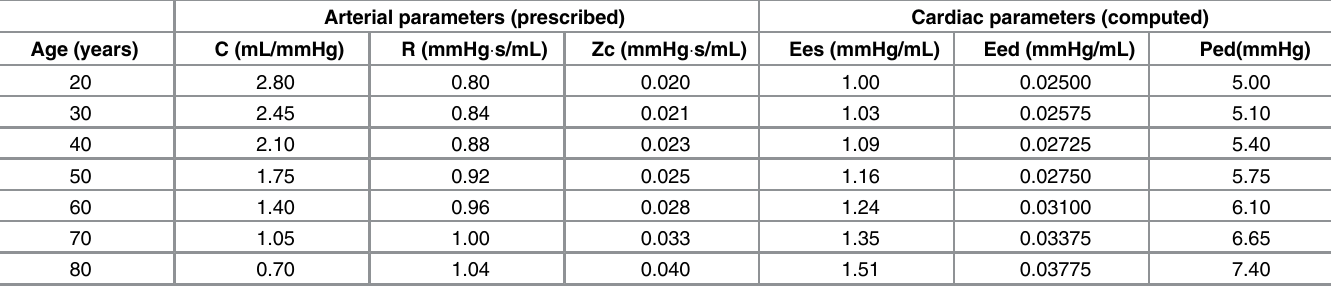
Table 1. Arterial and cardiac model parameters at different ages.